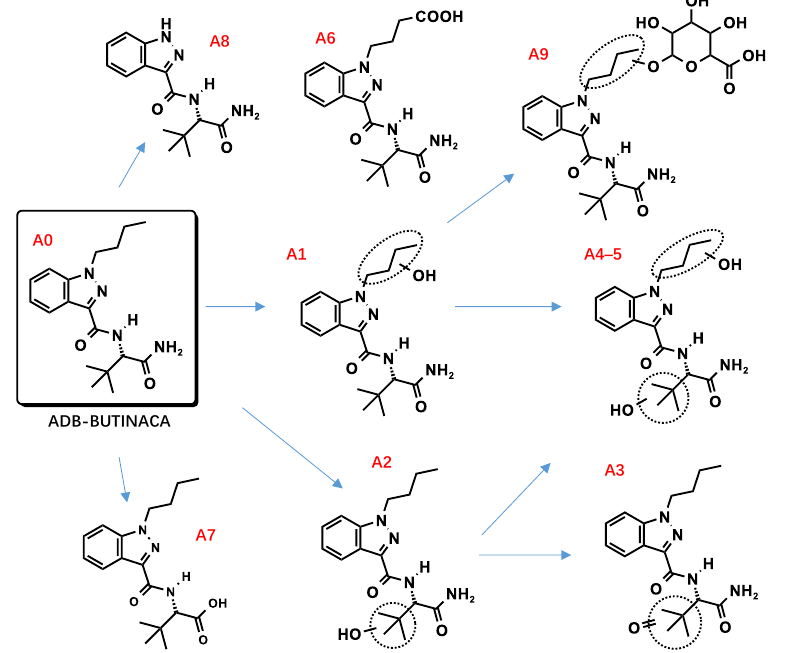
Figure 3. Proposed metabolic pathway of ADB-BUTINACA.